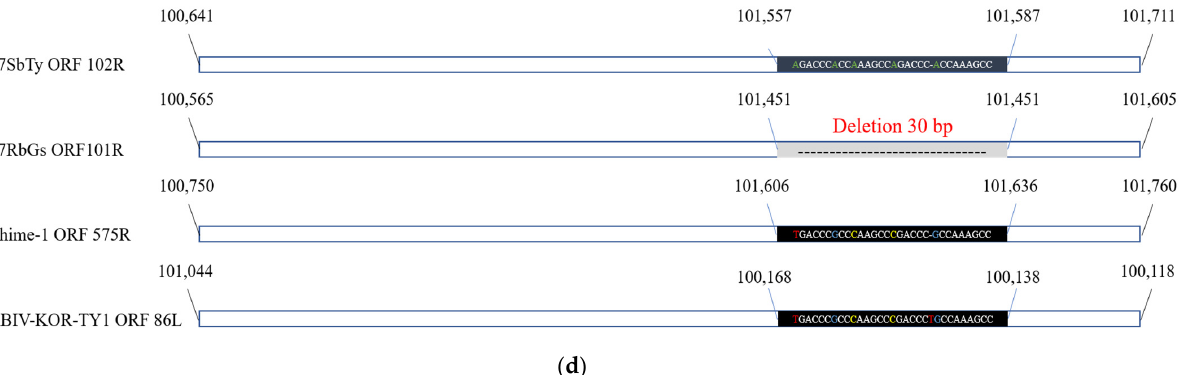
Figure 5. Schematic representation of insertion/deletion mutations (InDels) (>10 bp) in the coding regions as ( a ) ORF 014R, ( b ) ORF 053R, ( c ) ORF 054R and ( d ) ORF 102R based on the 17SbTy when compared with the genomes of 17RbGs and two representative RSIVs (Ehime-1 [RSIV subtype I] and RBIV-KOR-TY1 [RSIV subtype Ⅱ ]). Numbers indicate the positions of the InDels in the genome; white bars represent genome fragments, black bars denote insertions, and gray bars represent deletions.